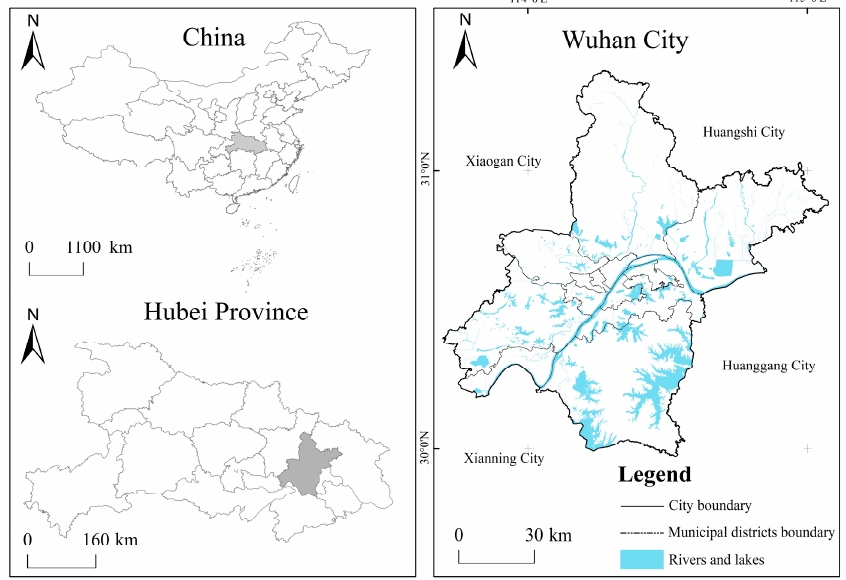
Figure 1. Location Map of Wuhan City.